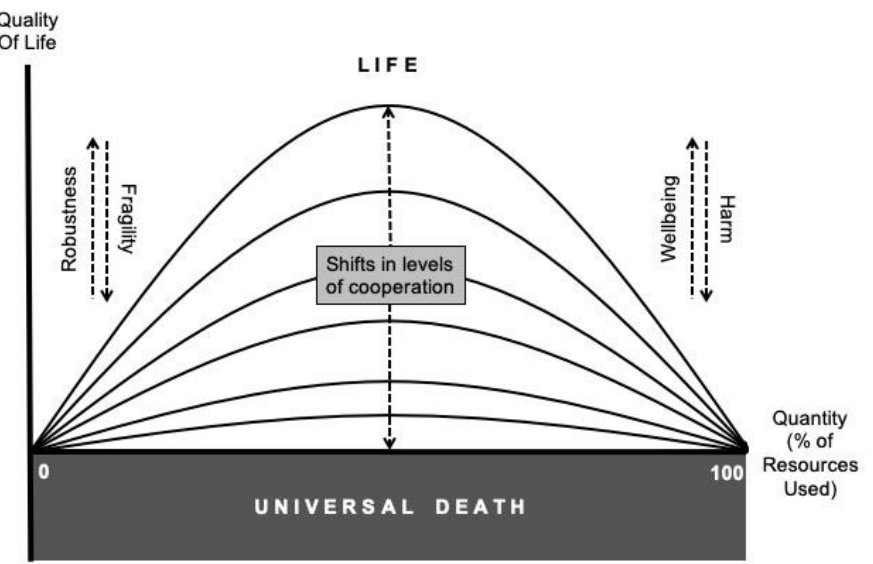
Figure 4: Evolutionary View of